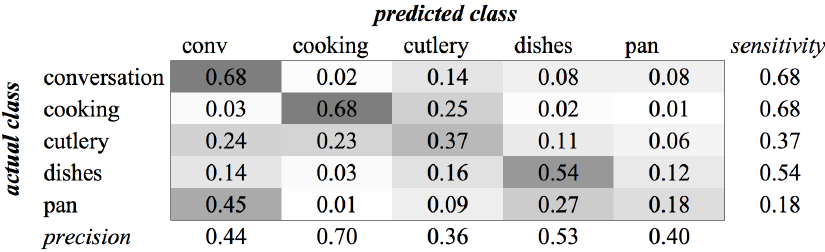
Figure A13. SVM confusion matrix of category Kitchen for MFCC feature type.